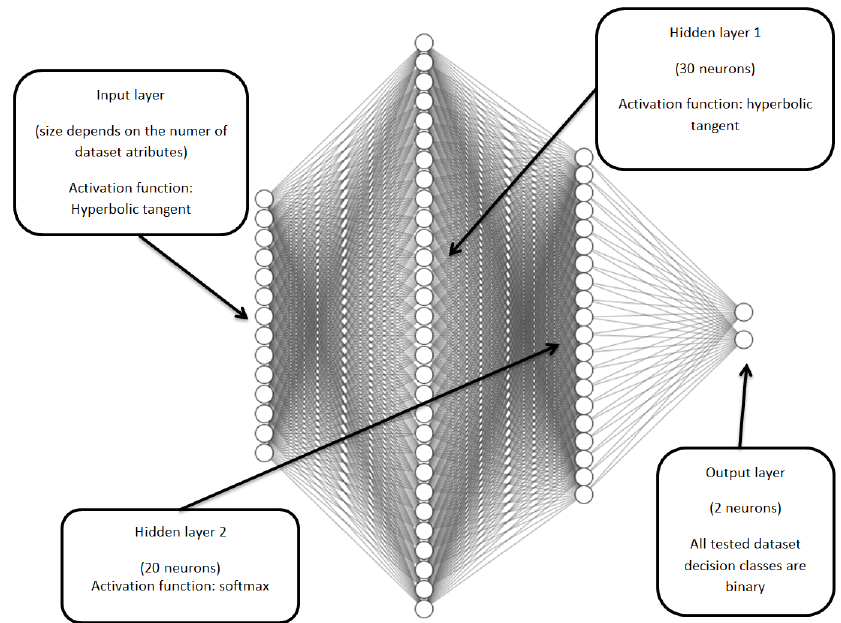
Figure 2. A diagram of the neural network used to learn the Australian credit system. Neural networks for the other two systems differ only in the number of inputs determined by the number of conditional attributes.